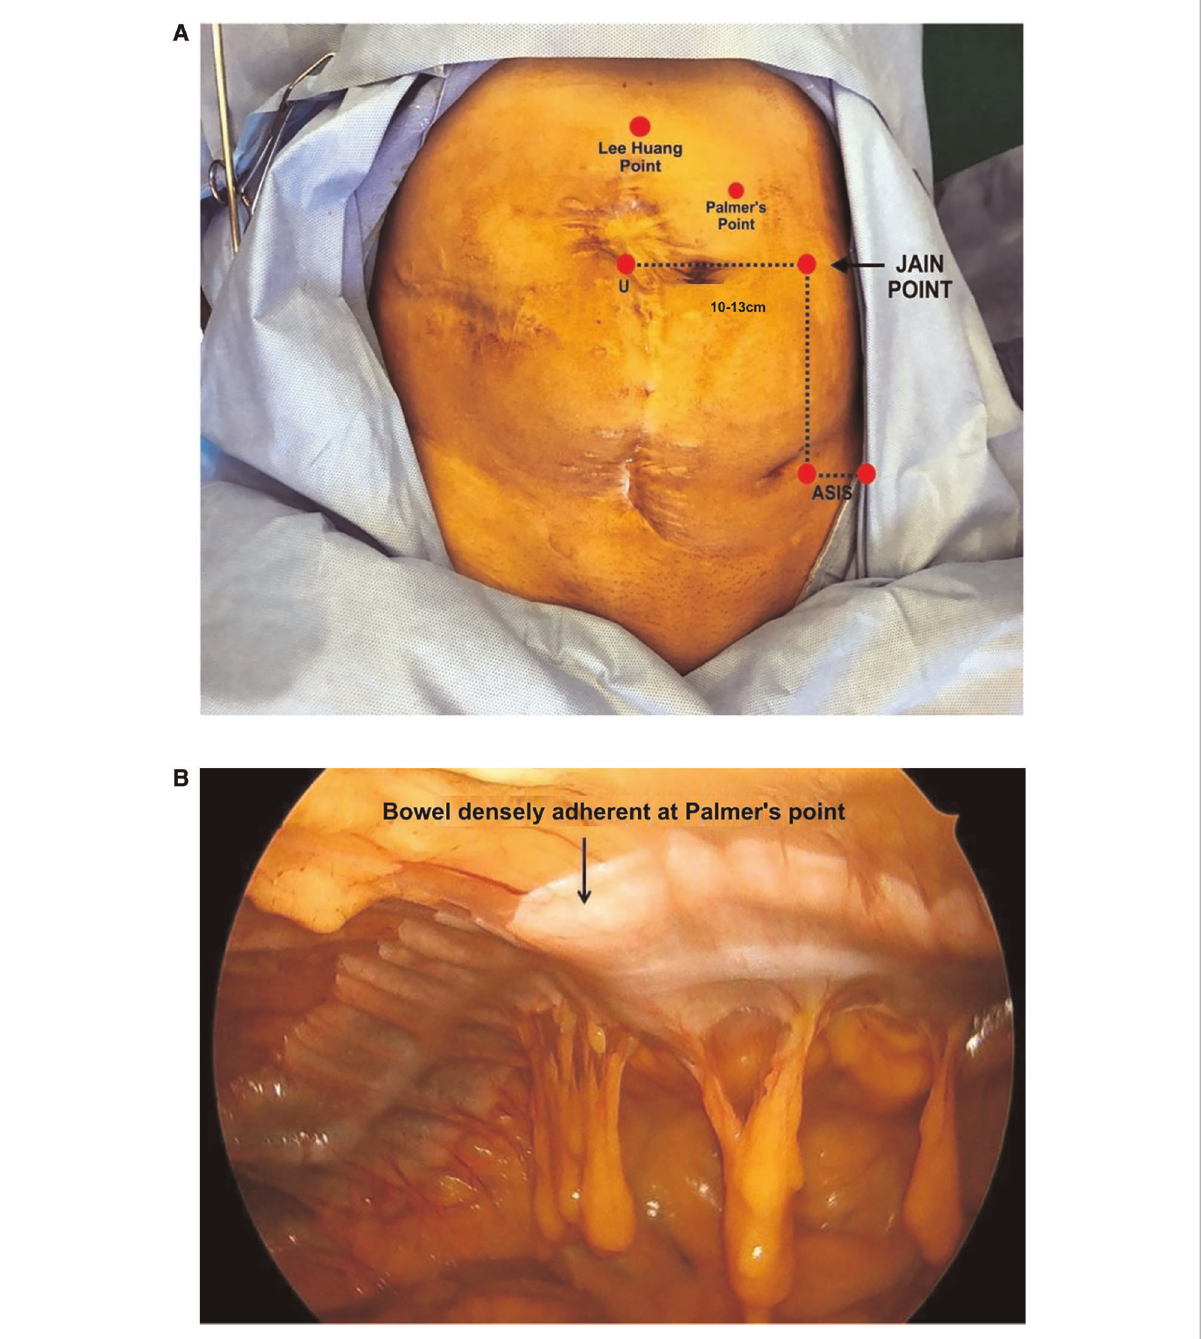
showing bowel loops stuck over the upper abdomen. The Jain point avoids Type IIA bowel